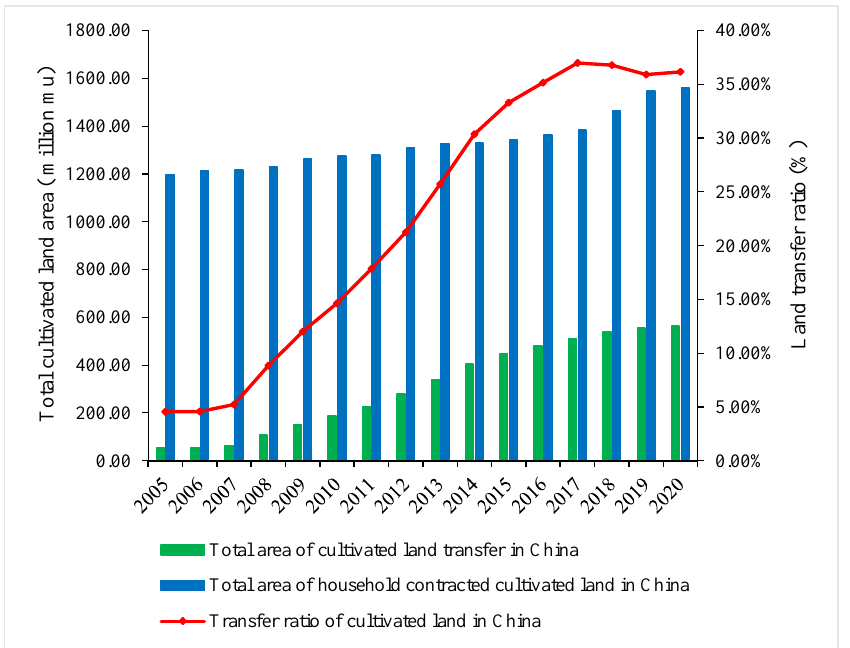
Figure 1. Farmland transfer activities in China from 2005 to 2020. Source: China Rural Statistical Yearbook; China Rural Business Management Statistics Annual Report; Statistical Annual Report on China ’ s Rural Policy and Reform.